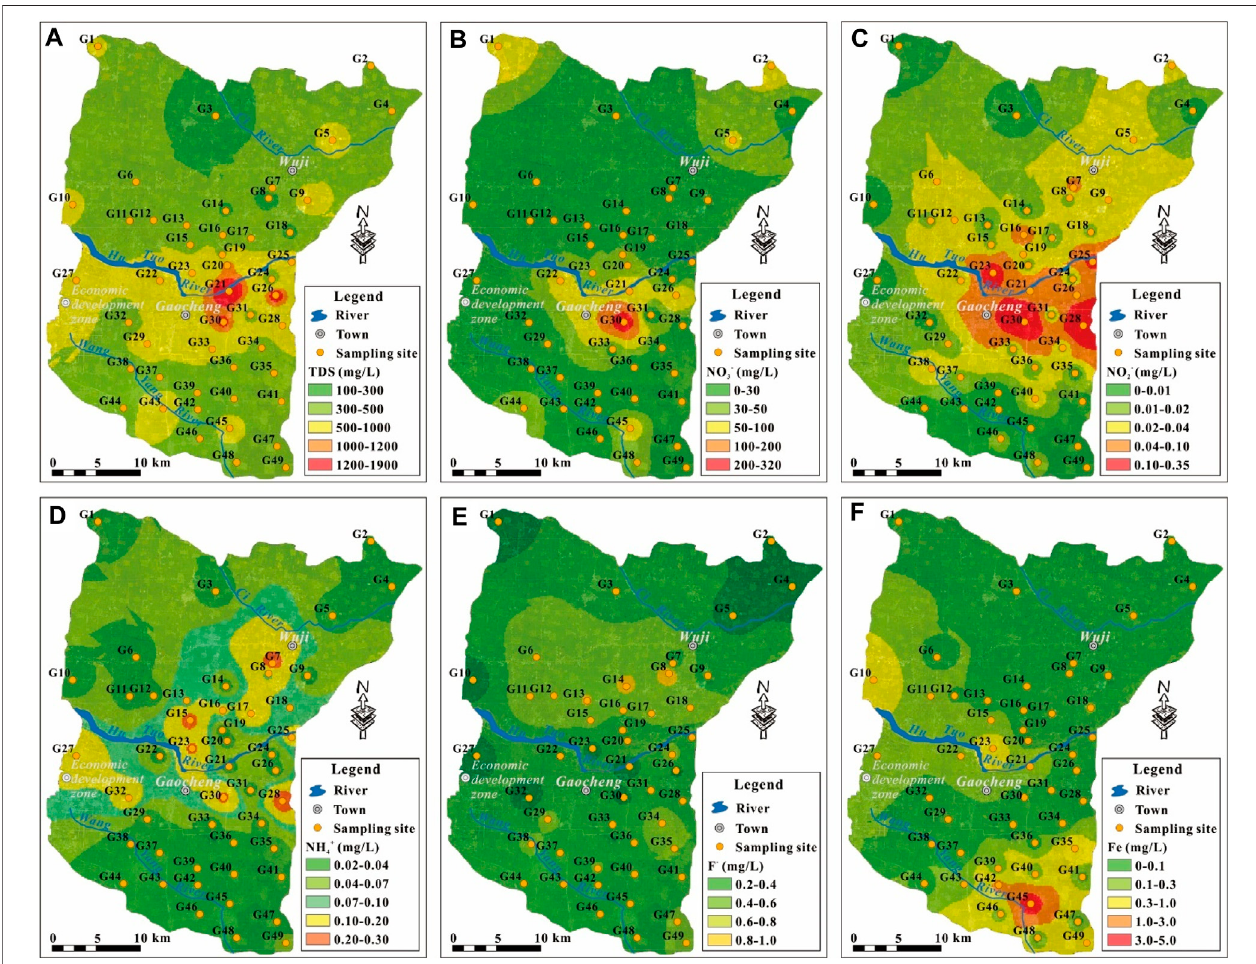
FIGURE 3 | Geospatial distribution of (A) TDS, (B) NO 3 − , (C) NO 2 − , (D) NH 4+ , (E) F, (F) Fe of groundwater in the study area.